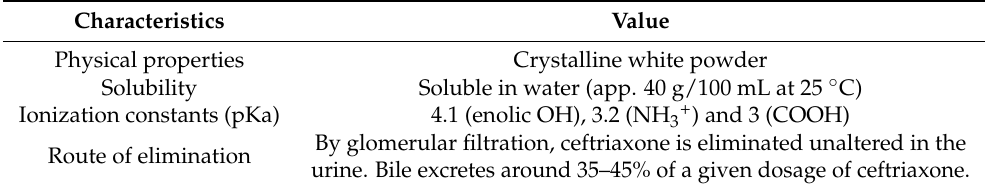
Table 1. Characteristics of ceftriaxone sodium